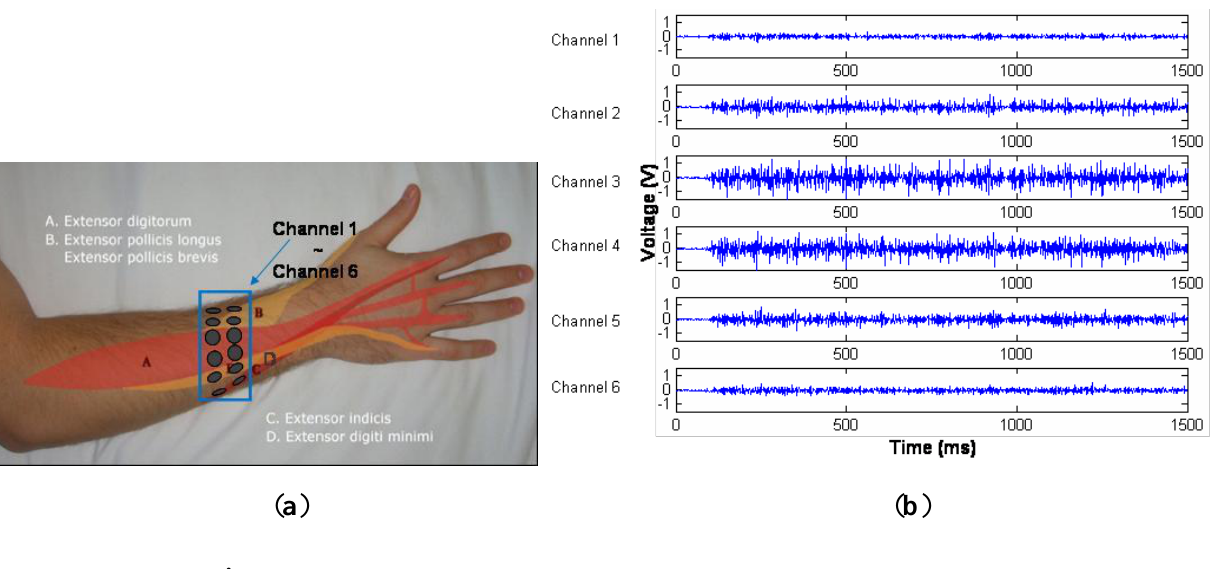
Figure 3. ( a ) Six-channel sEMG electrode arrangement. ( b ) Six-channel conditioned sEMG signals for ball-grasping